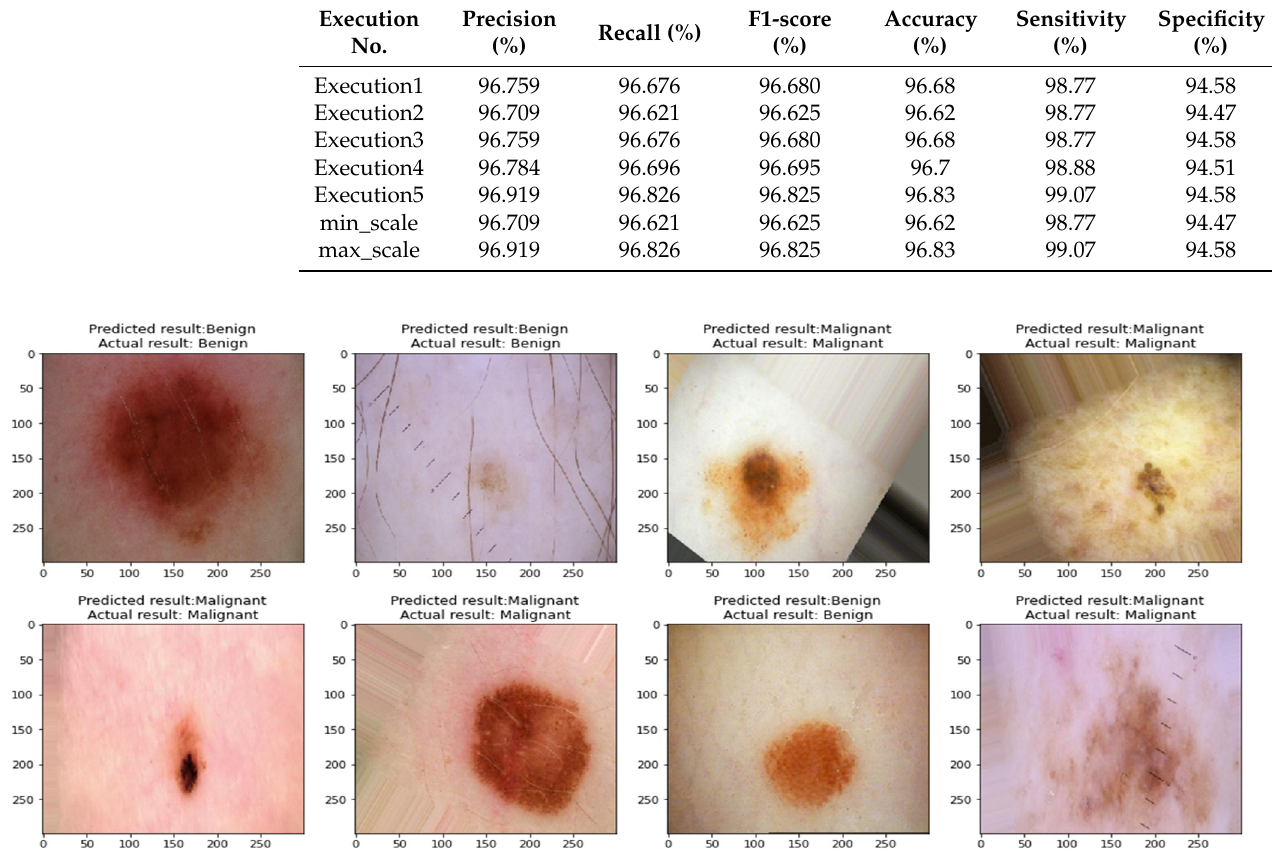
Table 6. Repeated tests to measure the performance of the Xception model for classification of skin cancer images.